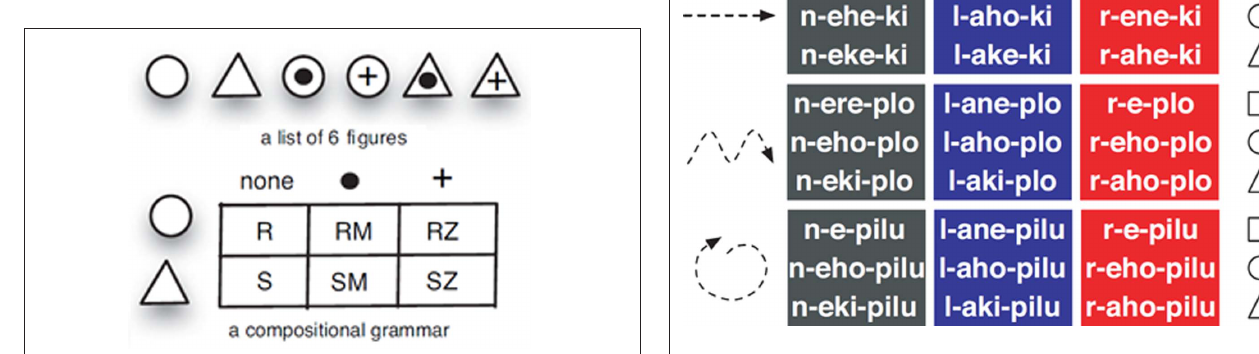
Figure 3 | examples of figures and code systems from Selten and Warglien (2007). (Top row) Example of six visual tokens made up of two shapes and three inserts. (Bottom row) Example of a compositional grammar in which R signifies circle, S signifies triangle, M signifies • and Z signifies + . (Adapted from Selten and Warglein, 2007).